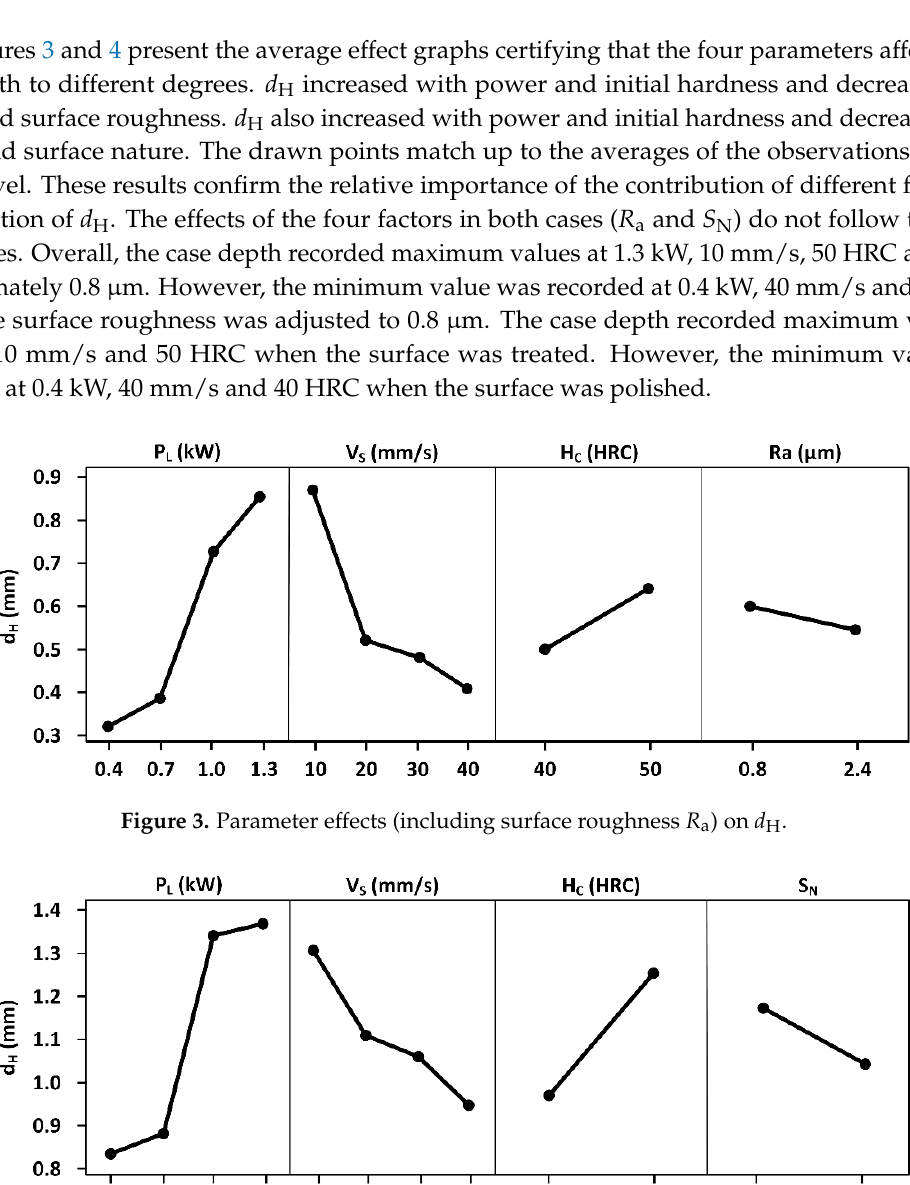
Figure 4. Parameter effects (including surface nature S) on d H .